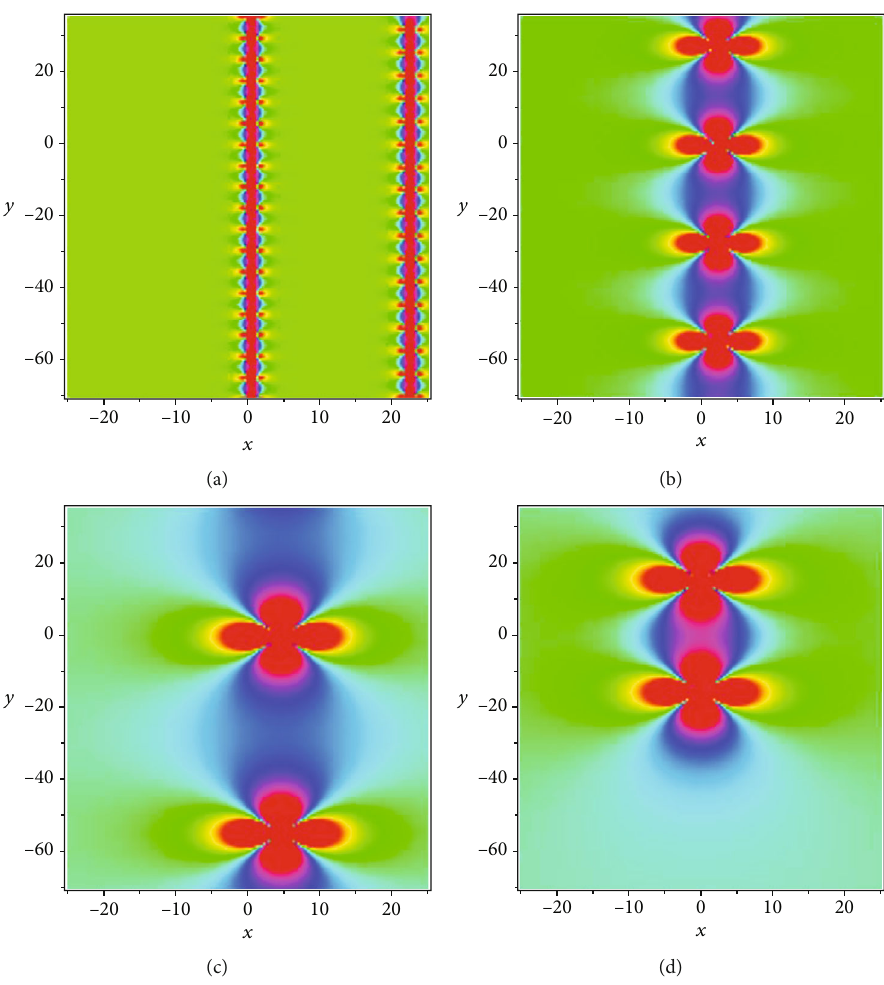
ffiffiffi p 3 : (a) α 1 = α 2 = 0 : 45 , (b) α 1 = α 2 = 0 : 1 ,